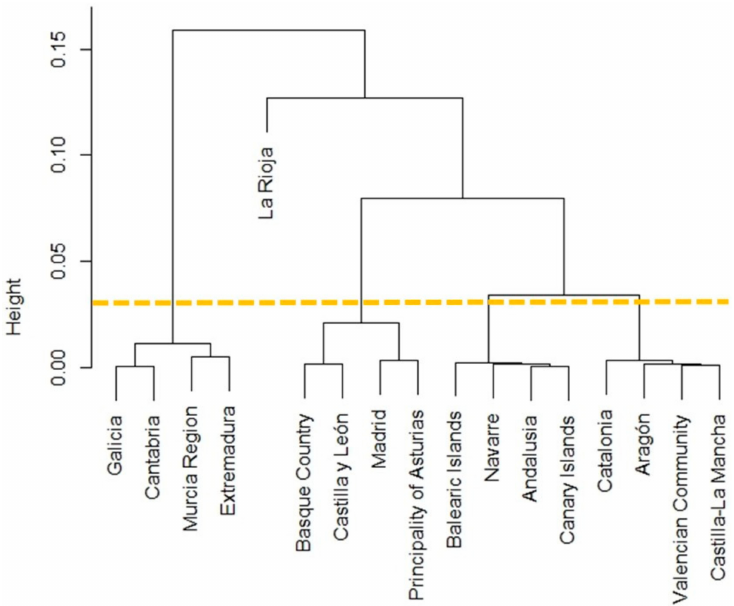
Figure 2. Dendrogram showing the conclusive groups obtained by the cluster